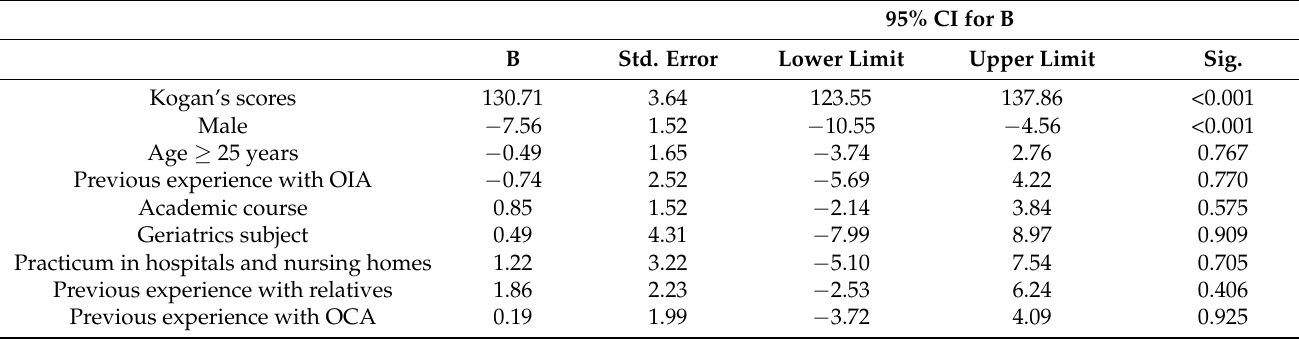
Table 3. Linear regression model of the total Kogan’s